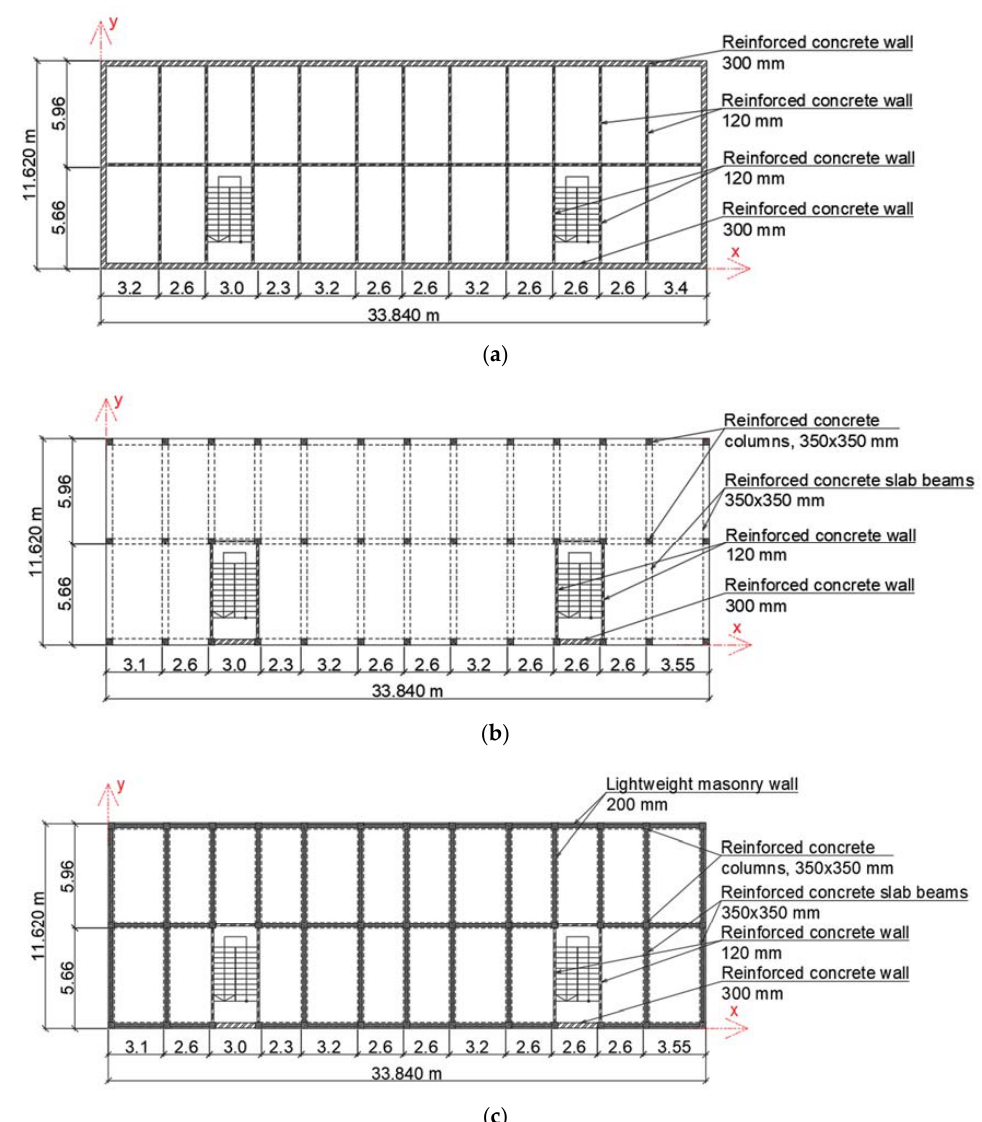
Figure 2. Principal schemes of investigated FEM reference models: ( a ) cellular structure, RC build ‐ ing (reference model #1); ( b ) frame structure, RC building (reference model #2); ( c ) frame structure b ) frame structure, RC building (reference model #2); ( c ) frame structure with with masonry infill walls, RC building (reference model #3). (reference model #1); ( masonry infill walls, RC building (reference model